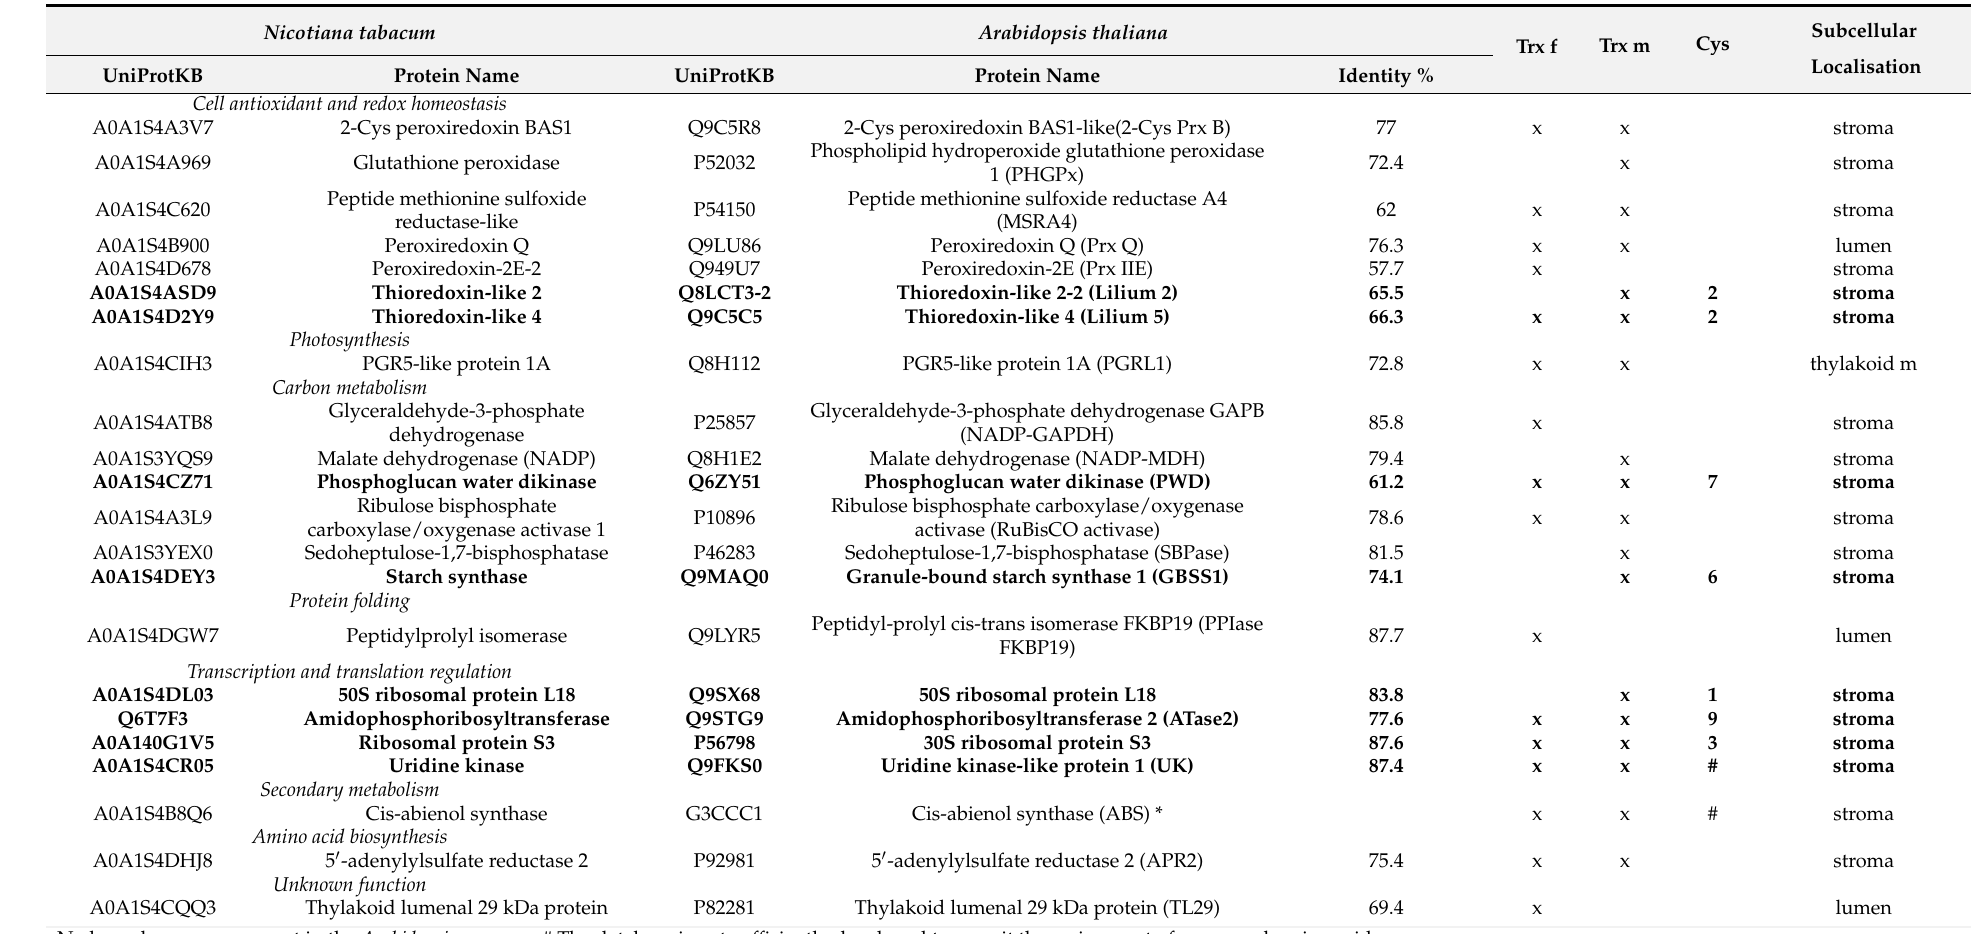
Table 1. List of chloroplast proteins identified as potential Trx f and Trx m targets by in vivo interaction with the monocysteinic mutant through agroinfiltration of N. benthamiana plants. The table shows identified proteins in an N. tabacum database, as well as their orthologs in Arabidopsis , with the corresponding identity %. The specificity for each isoform and the corresponding subcellular localisation inside the chloroplast are indicated. The potential new targets are indicated in bold and the number of conserved Cys residues is shown. Thylakoid m: thylakoid